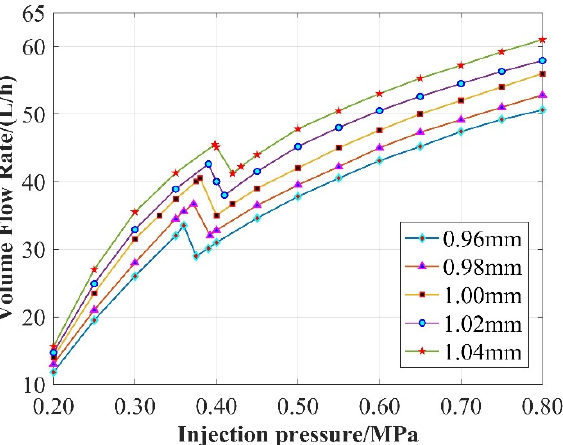
Figure 11. Relationship between the volume flow rate and injection pressure of single small devia- tion cylindrical nozzles. cylindrical